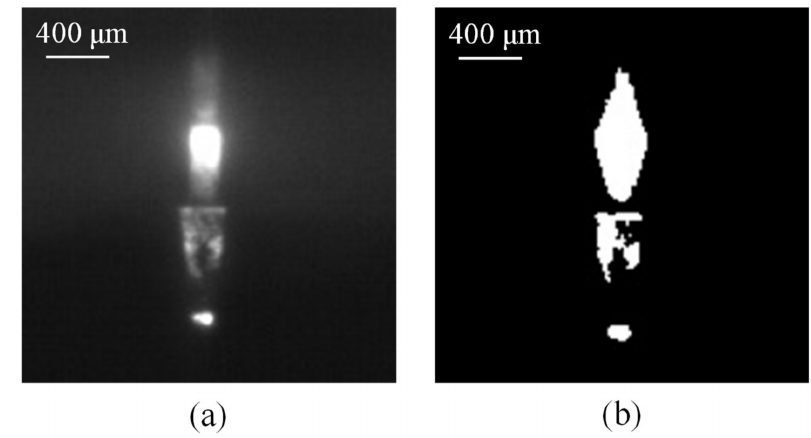
Figure 5. The arcing plasma area of an image of quartz glass in the radial direction ( a ) acquired by an industrial camera and ( b ) after the thresholding